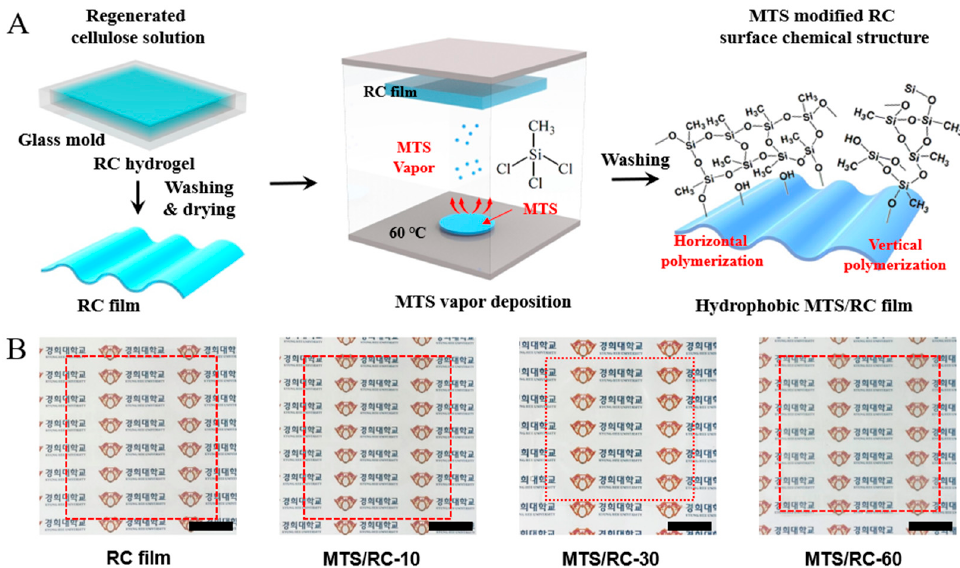
Figure 1. ( A ) Fabrication of the hydrophobic MTS/RC films via CVD. Firstly, the cellulose solution was poured into a glass mold and coagulated into RC films. Next, the dried RC film was placed in a desiccator, and MTS was vapor-deposited on the surface of the RC film for 10, 30, or 60 min. ( B ) Photographs of the pristine RC film and the MTS/RC-10, MTS/RC-30, and MTS/RC-60 films. Inset scale bar: 2 cm. Thickness of the RC and MTS/RC films: 70 µm.